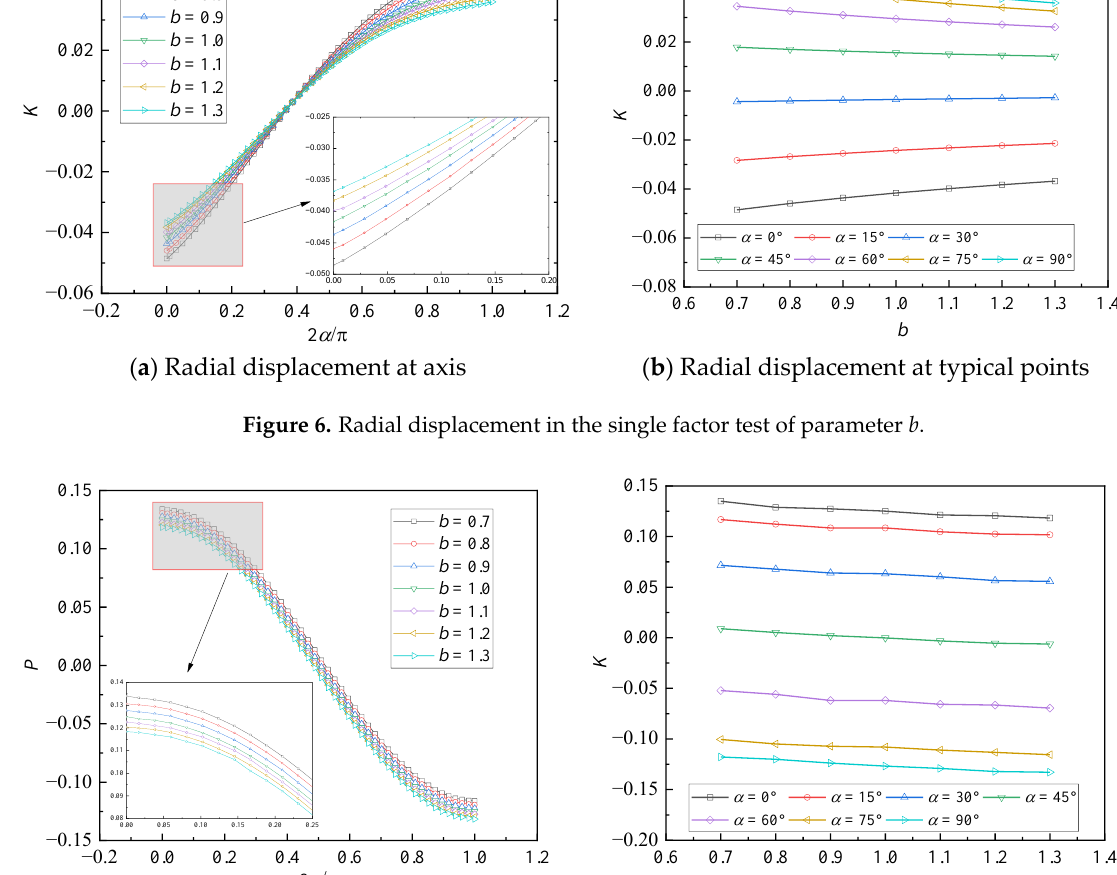
( b ) Section moment at typical points Figure 7. Section moment in the single factor test of parameter b. Figure 7. Section moment in the single factor test of parameter